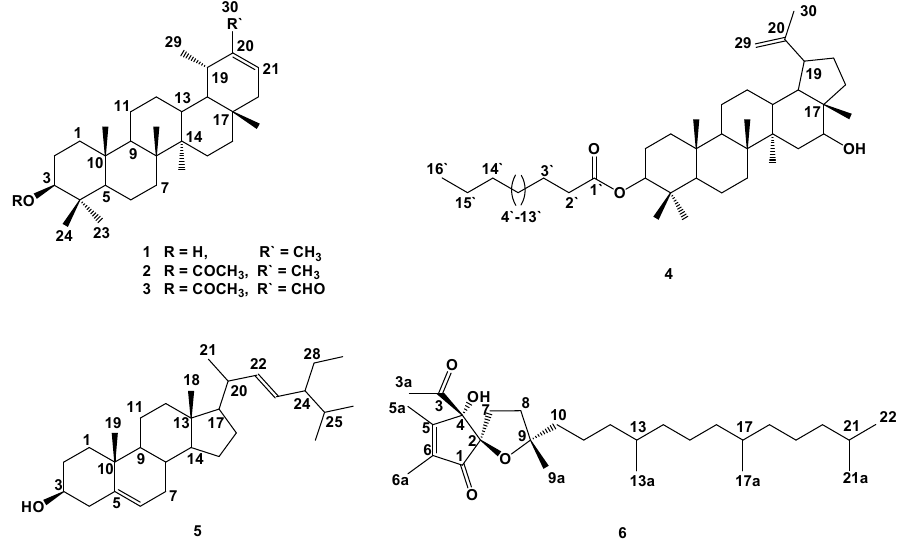
Figure 1. Chemical structures of the isolated compounds ( 1 - 6 ).